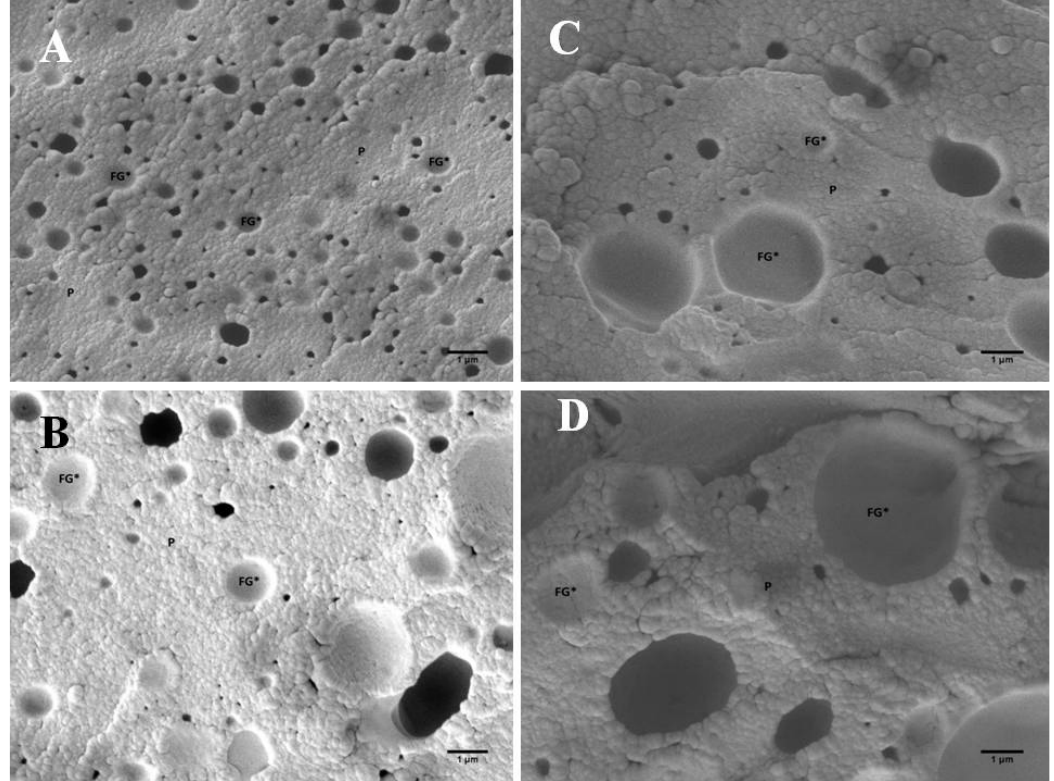
Figure 5. Scanning electron microscopy images of the model processed cheese (the scale bars repre ‐ sent 10 μ m; 1000× magnification). ( A ) Sample with emulsifying salts; ( B ) sample with agar; ( C ) sam ‐ ple with κ‐ carrageenan; ( D ) sample with gelatin; FG* (and white arrows)—void space of fat glob ‐ ules; P—protein structure; PPS—protein ‐ polysaccharide structure.